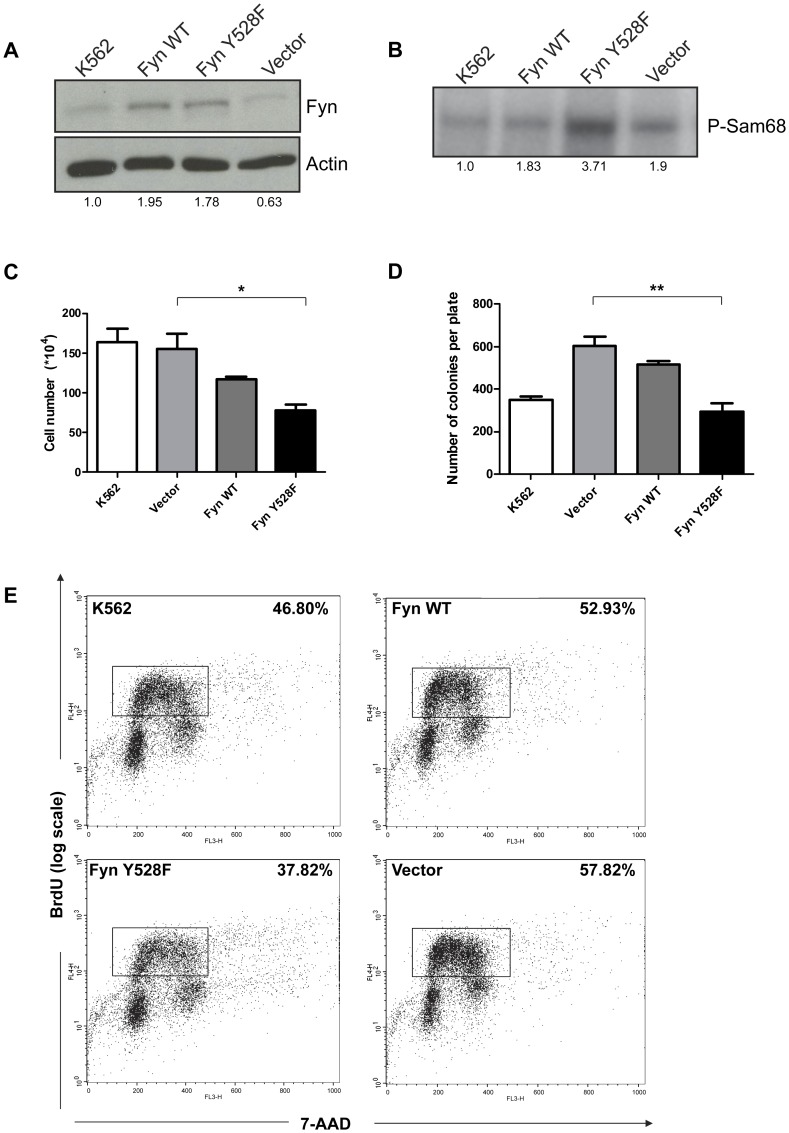
Overexpression of constitutively active Fyn kinase in K562 cells decreases cell growth.K562 cells were transduced with vector, wild-type (Fyn WT), and constitutively active Fyn (Fyn Y528F). (A) Fyn protein expression was evaluated in total cell lysates (100 µg) by Western blot analysis using an antibody specific for Fyn. Actin was used as a loading control. Densitometry was performed using ImageJ and the blot is representative of three independent experiments. (B) Protein lysates from K562 cells transduced with vector, wild-type Fyn, and constitutively active Fyn were subjected to immunocomplex kinase assays using Sam68 as a substrate. Phosphorylated Sam68 was detected by autoradiography. The results are representative of three independent experiments. (C) Fyn overexpressing K562 cells were plated at 100,000 cells/mL in a 12 well plate and viable cells were counted after 72 hours. *p<0.01, n = 3, mean+SEM. (D) Fyn overexpressing K562 cells lines were suspended in MethoCult GF H4434 medium and colonies were counted five days after plating. **p<0.001, n = 3, mean+SEM. (E) Fyn overexpressing K562 cells were pulsed for 30 minutes with 10 µM BrdU and double stained with an APC-conjugated BrdU antibody and 7-AAD for cell cycle. Dot plots are representative of three independent experiments.